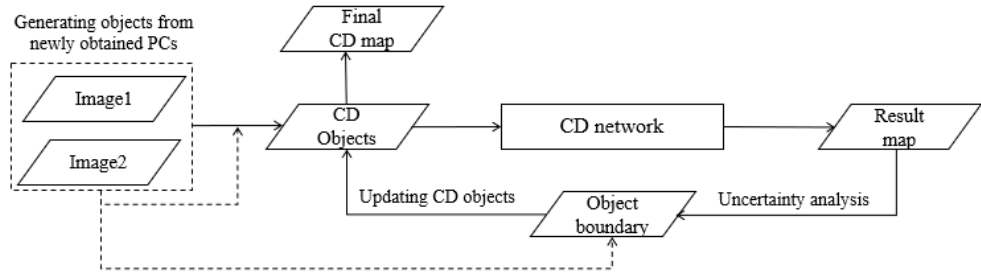
Figure 1. Framework of the proposed method. The objects were obtained from principal components (PC) of two temporal images, and the CD objects are used as label data for the deep learning network. The result map of the deep learning network is integrated with the object boundary to update the CD objects, which involve change or no-change classes over a specific percentage for the entire region. This process is repeatedly performed until all the objects of the entire image are classified into change or no-change classes.